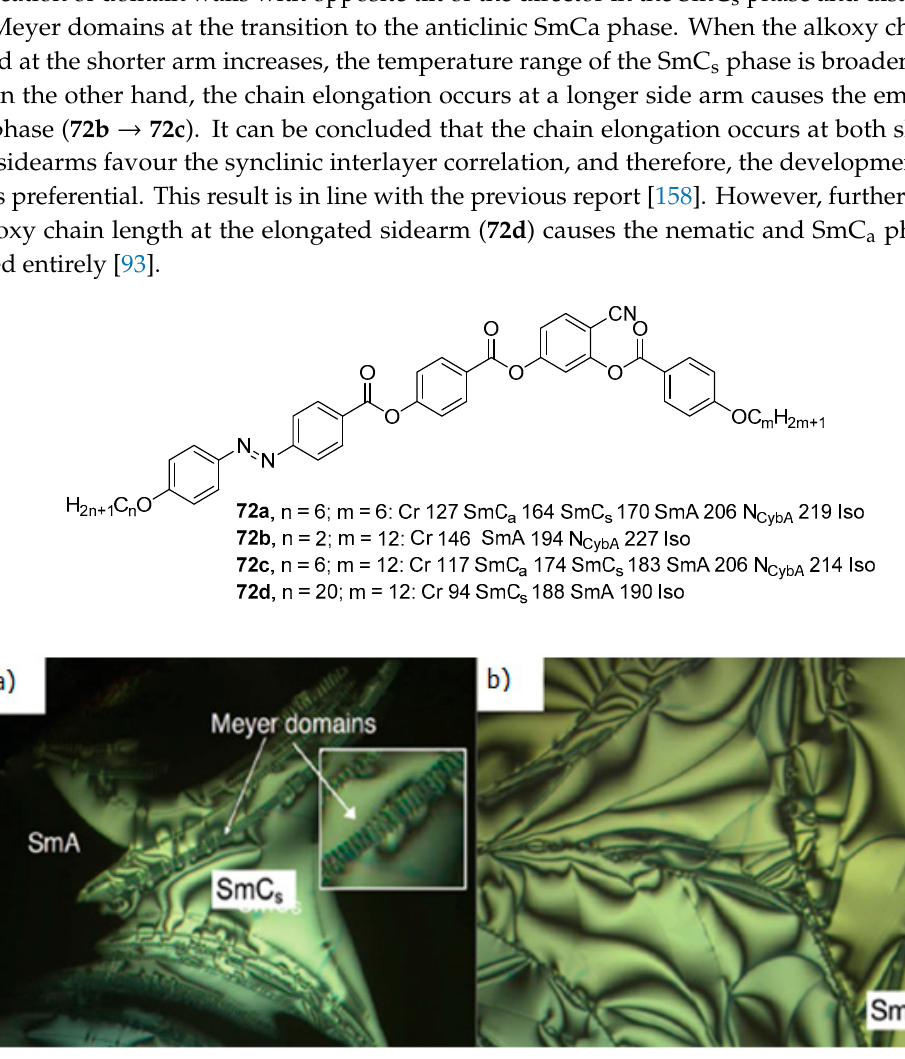
Figure 17. POM images of a freely suspended film of compound 72a ( a ) in the SmA-SmC s transition at T = 170 °C, showing the Meyer domains growing from the layer steps and ( b ) in the SmC a phase at T = 147 °C. (Reproduced with permission from ref. [93], copyright The Royal Society of Chemistry 2017, https://doi.org/10.1039/C7TC01816A).